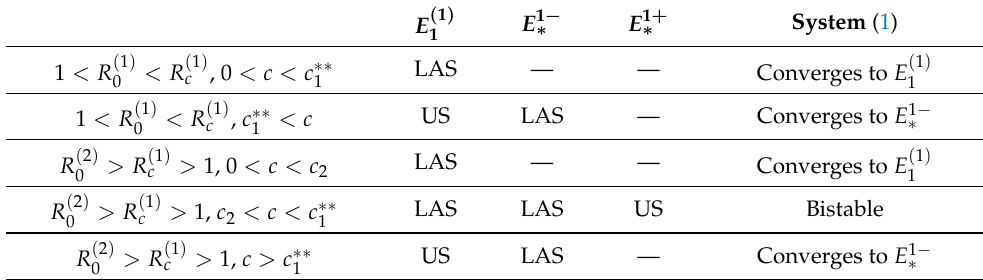
Table 2. The stabilities of the equilibria and the behaviors of system (2) in the case that R ( 2 ) E 2 − ∗ E 2 + ∗ System (2) E 1 ( 2 ) GAS — — Converges to E ( 2 ) < R ( 2 ) < c < c ∗∗ 1 < R c , 0 2 0 ( 2 ) ∗∗ < R ( 2 ) < c US GAS — Converges to E 2 − ∗ 1 < R c , c 2 0 GAS — — Converges to E ( 2 ) GAS GAS US